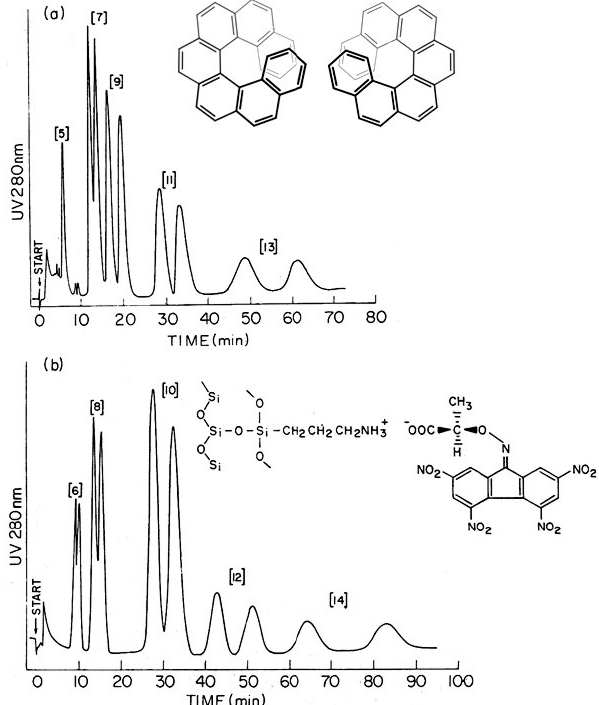
Figure 1. Enantiomeric separation of racemic [5]–[14]helicenes on (R )-( − )-2-(2,4,5,7-tetranitro-9- fluorenylideneamino-oxy)propionic acid (TAPA) linked to silica gel [4]. ( a ) odd numbers; ( b ) even numbers. Insertions: [7]helicene and TAPA.